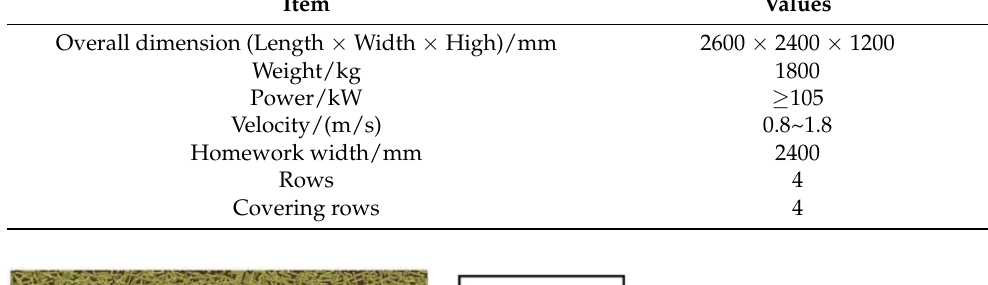
Figure 3. Structure of the wide-boundary planter with crushed straw inter-row mulching. Figure 4. Schematic diagram of the distribution of straw belts and seeding belts on the ground after sowing. Table 1. Main technical parameters.